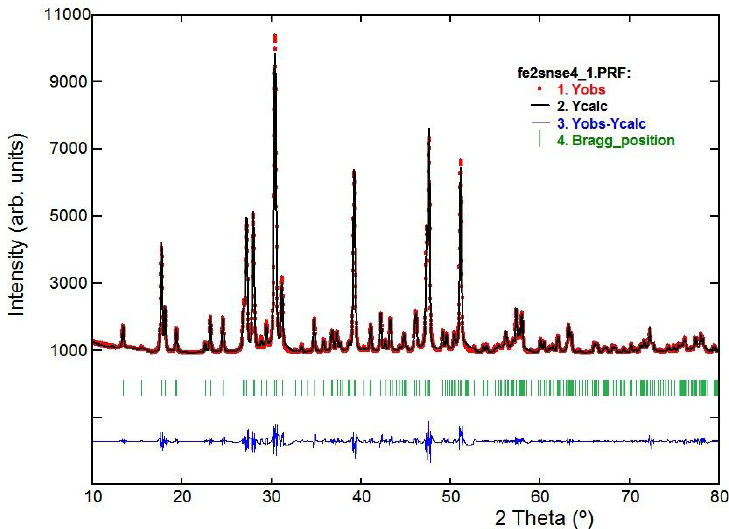
SnSe . The Bragg reflections 2 4